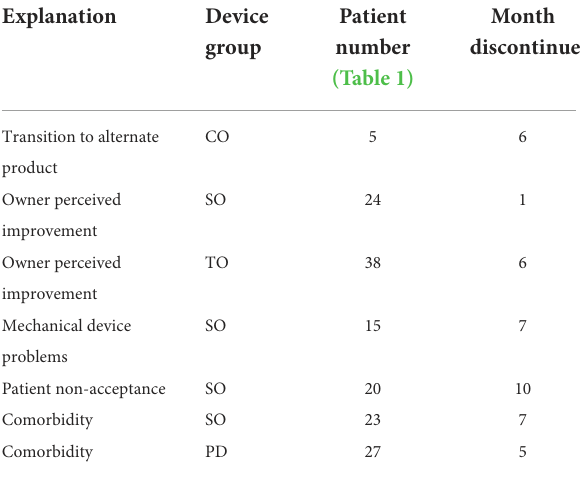
TABLE 3 Explanations and timeline for discontinuation of device use in seven patients prior to veterinary instruction.